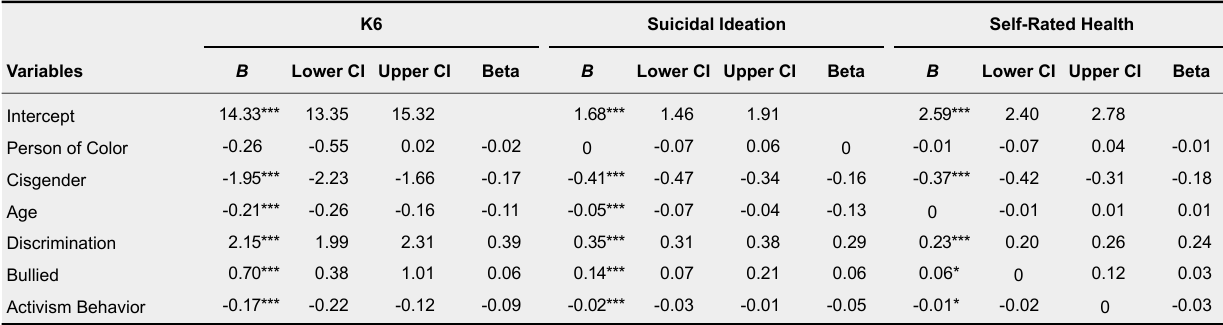
Multivariate Regression Models Testing Associations Between Discrimination, Bullying, Activism and Health Outcomes